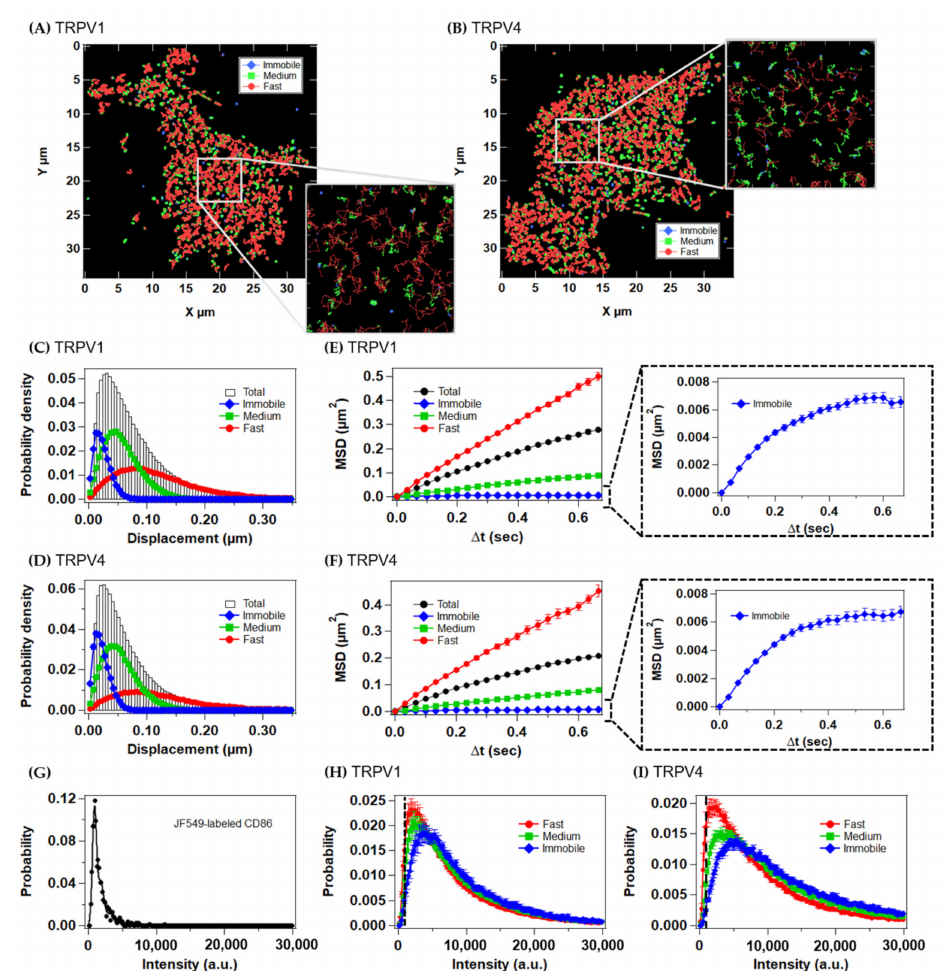
Figure 3. VB-HMM analysis of the trajectories of TRPV1 and TRPV4 molecules. ( A , B ) Each step in the trajectories was categorized into three diffusion states. The immobile, medium, and fast states are shown in blue, green, and red, respectively. ( C , D ) Histogram of the displacement of JF549-labeled TRPV1 ( C ) and TRPV4 ( D ) at the basal level. ( E , F ) MSD– ∆ t plots of each diffusion state of JF549-labeled TRPV1 ( E ), JF549-labeled TRPV4 ( F ). Data are means ± SEM of 17–22 cells. ( G ) Intensity histograms of JF549-labeled CD86 measured under the same conditions as described for TRPV1 and TRPV4. ( H , I ) Histogram of the intensity of JF549-labeled TRPV1 ( H ) and JF549-labeled TRPV4 ( I ) at the basal level. Dashed line represents the intensity of single molecules (896 a.u.) estimated from JF549-labeled CD86 (the monomeric